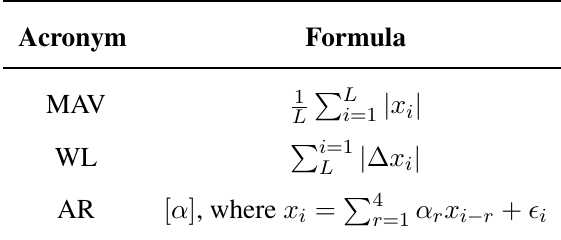
Table 1. Features extracted from each sEMG signal. WL, wavelength; AR, auto-regressive